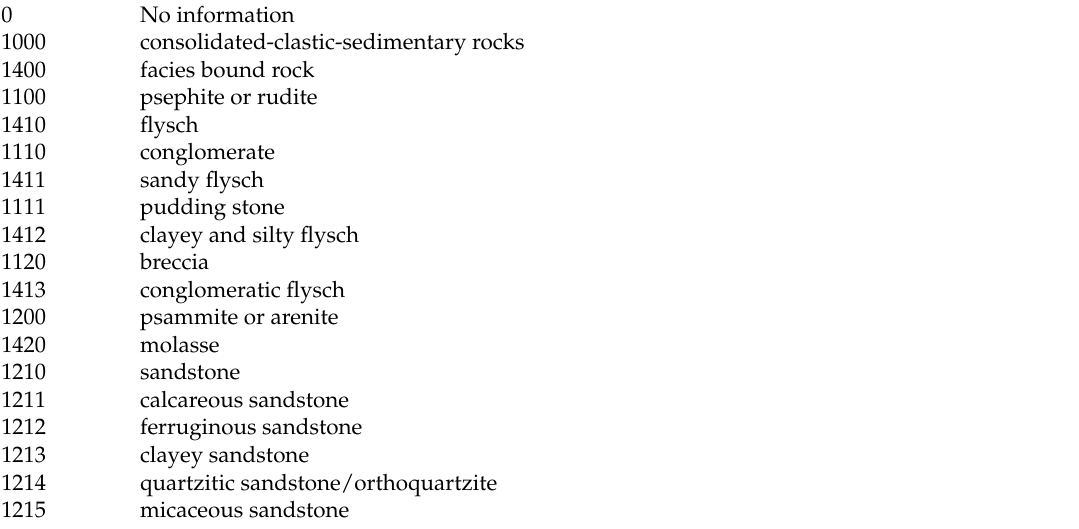
Table A1. PAR-MAT-DOM: Code for dominant parent material of the